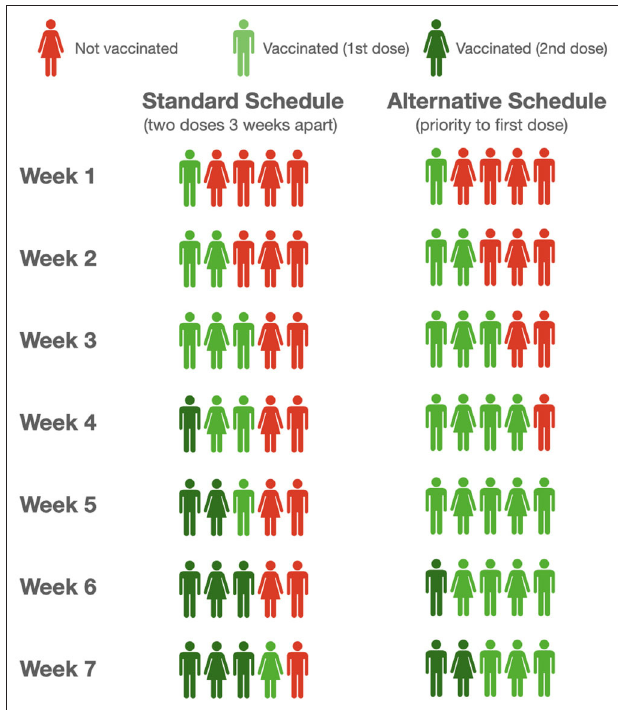
FIGURE 1 | Schematic illustration of standard and alternative schedule of